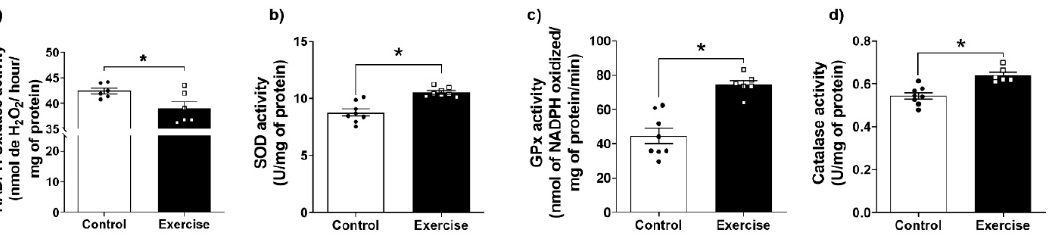
Figure 4. Aerobic exercise improved the antioxidant system in WAT. ( a ) NADPH oxidase activity; ( b ) Total superoxide dismutase (SOD)-; ( c ) Total catalase (CAT)- and ( d ) Total glutathione peroxidase (GPX) activities. The data were expressed as the mean ± standard error of the mean ( n = 8 animals/control and n = 8 animals/group). • —Control group; (cid:3) —Exercise group. * Statistical difference between